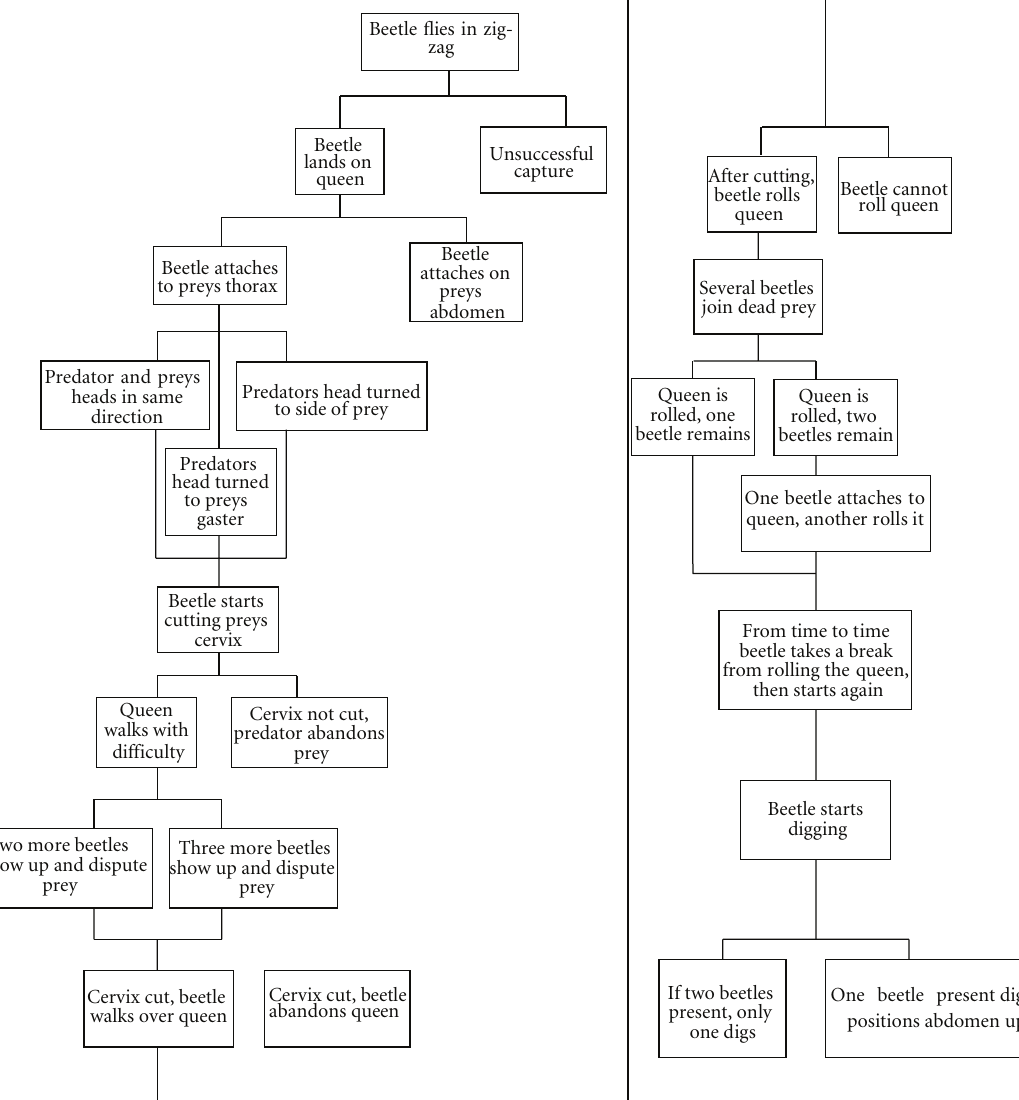
Figure 1: Fluxogram showing the behavior of Canthon virens preying on leafcutter ants ( Atta spp.).